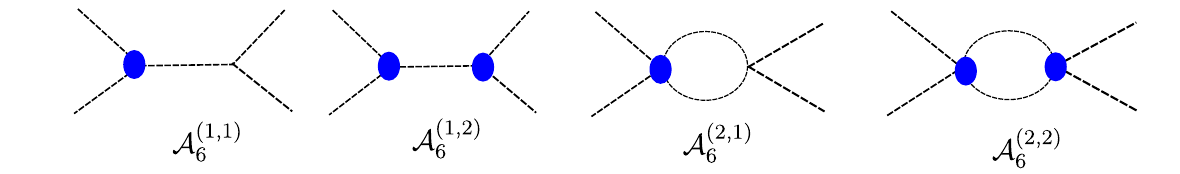
Fig. 1 Perturbative expansion of the EFT dim = 6 amplitudes, illustrating Eq. (2.8)